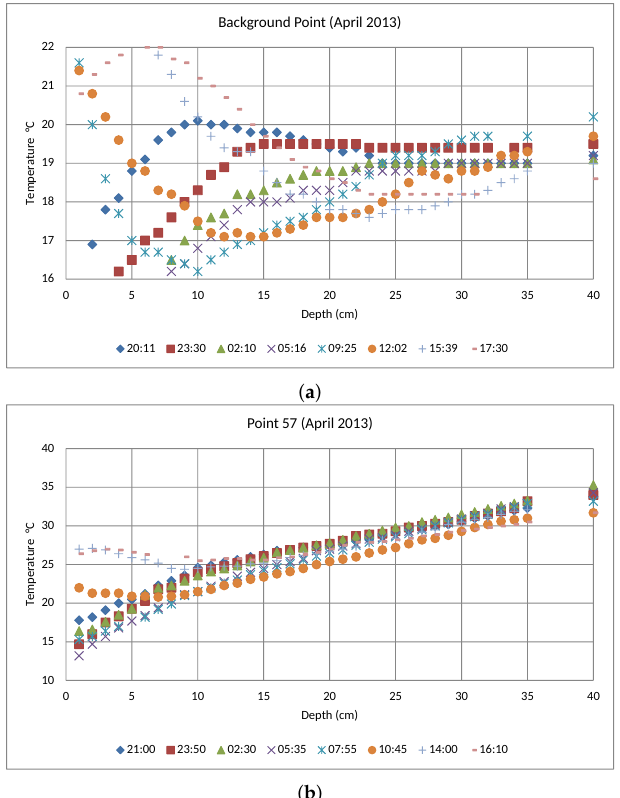
Figure 5. Results of thermal profile measurements on a 24 h campaign: in a background point (BG) ( a ); and in a point with a small thermal flux ( b ). At the bottom of the boxes, there are the hours of acquisition of each